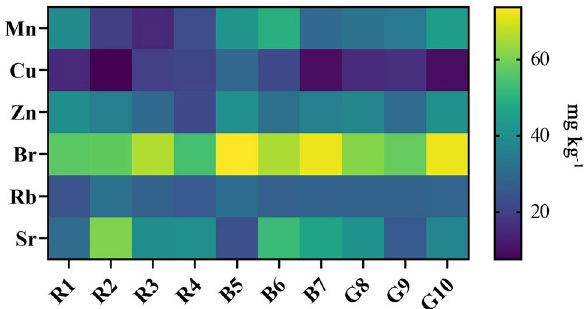
Figure 3. Heat map showing the concentrations (ranging from ~ 7.8 to 73.6 mg kg −1 ) of six elements found within the 10 algae species.